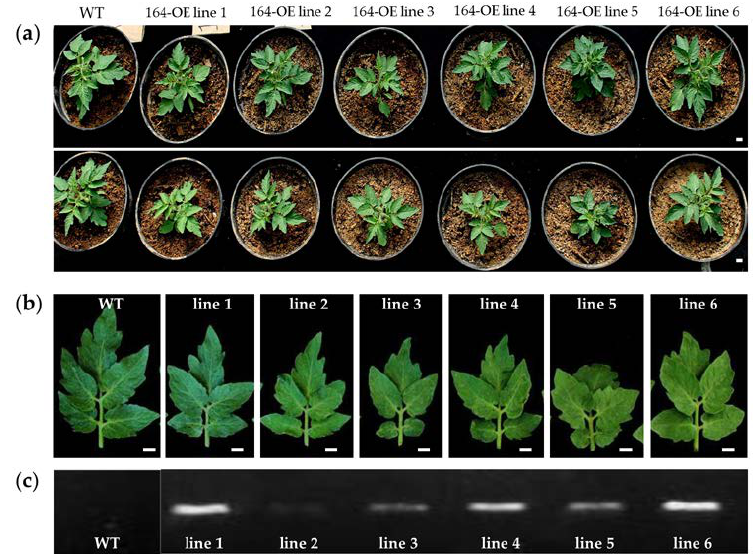
Figure 4. Phenotypic and molecular analyses of 164-OE tomato lines. ( a ) Plants and ( b ) leaves of different 164-OE tomato lines. Two plants of each line are shown, the leaf presented is the third leaf; ( c ) Detection of the BAR gene on the T-DNA in genomic DNA from the transgenic 164-OE tomato lines by PCR. Scale bars = 1 cm.